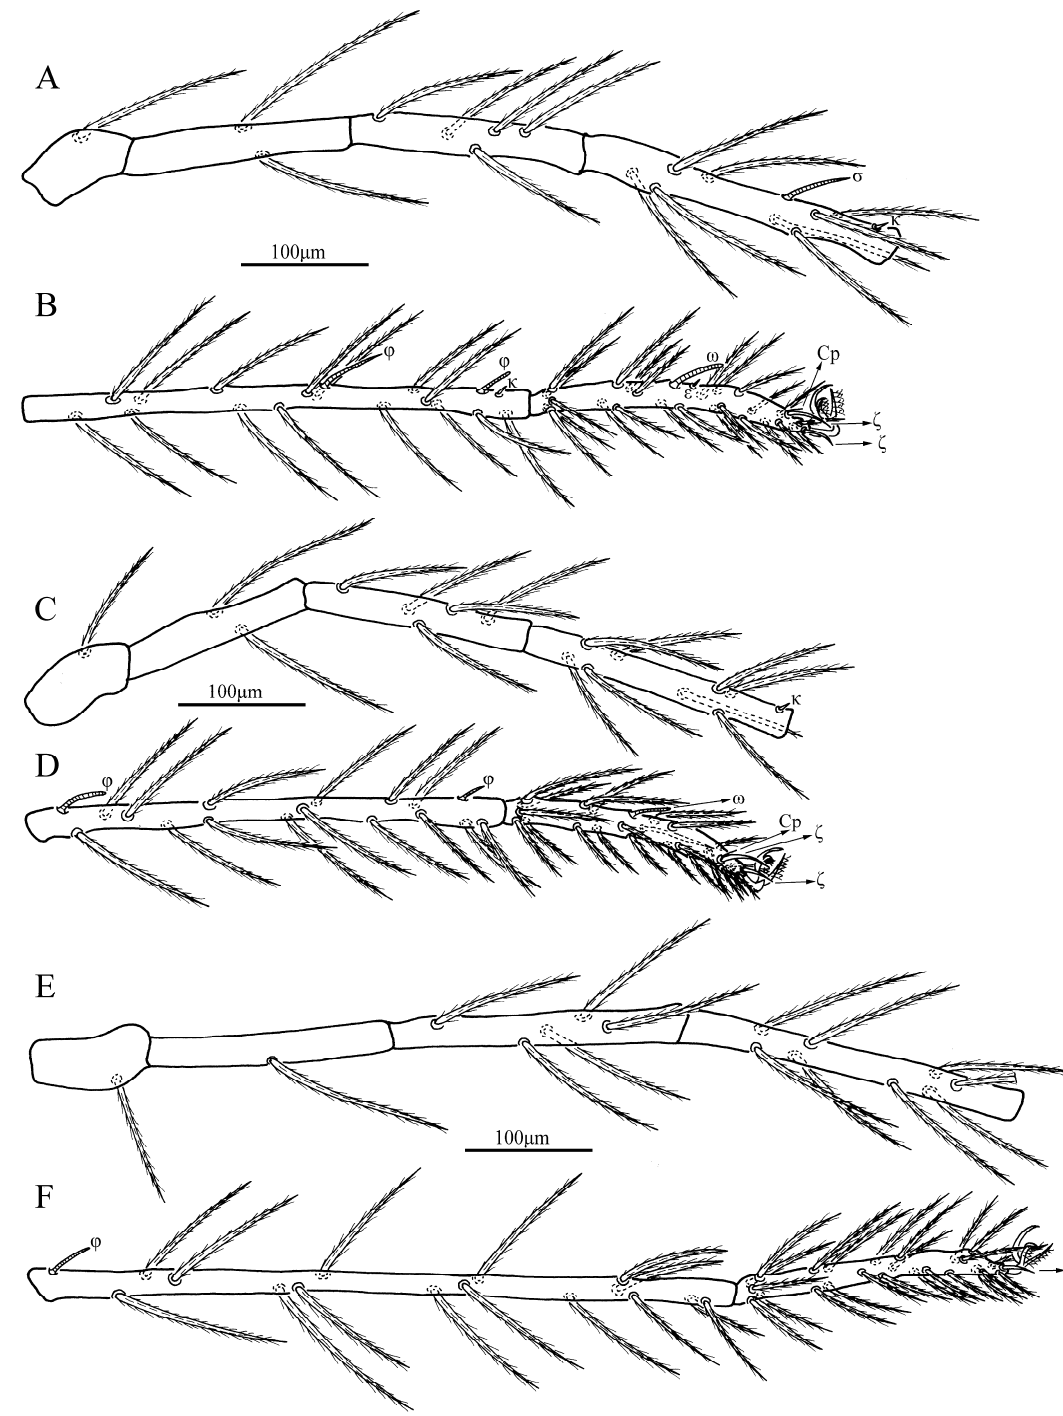
Figure 4. Eatoniana nanlingensis sp. nov. , larva. ( A ). Leg I, trochanter—genu. ( B ). Leg I, tibia—tarsus. ( C ). Leg II, trochanter—genu. ( D ). Leg II, tibia—tarsus. ( E ). Leg III, trochanter—genu. ( F ). Leg III, tibia—tarsus.